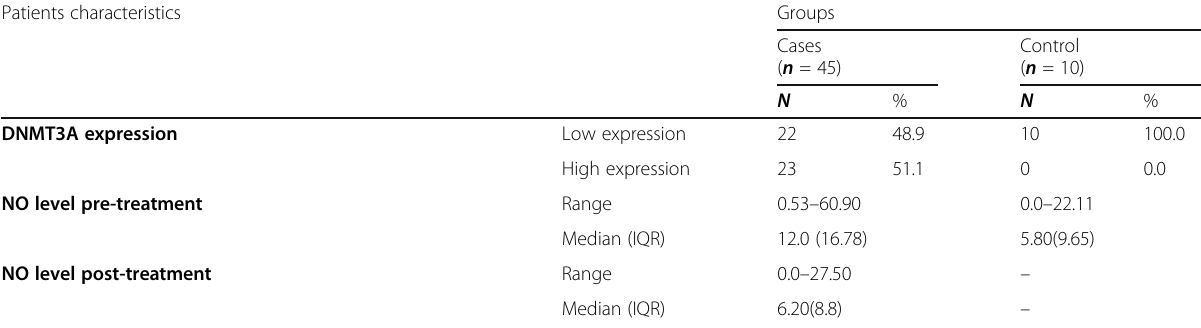
Table 1 Demographic data and patient characteristics (Continued) Patients